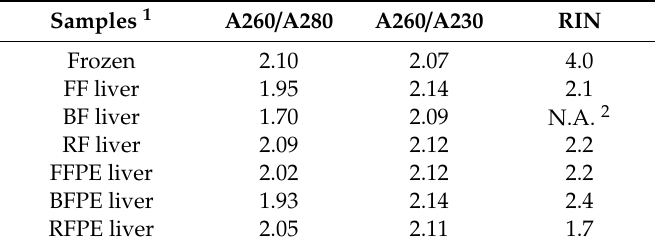
Table 5. Results of RNA quantification and integrity detection by BioAnalyzer in mouse